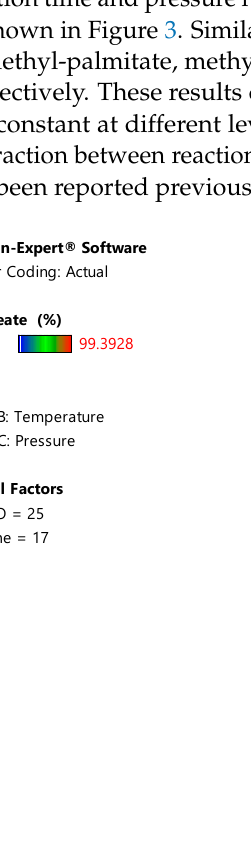
Figure 2. Response surface for the effect of reaction temperature and pressure on the yield of methyl-oleate.